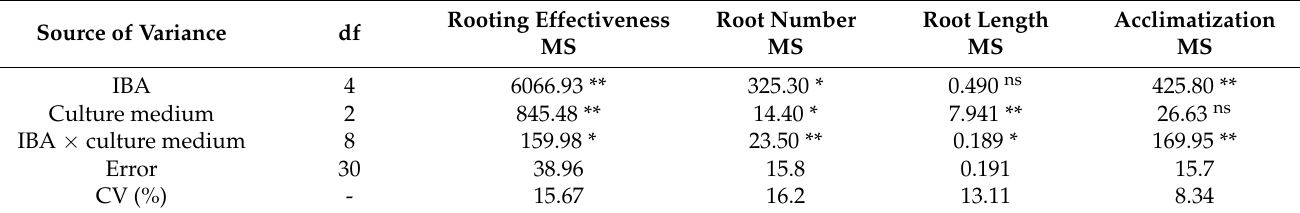
Table 3. Analysis of variance of the effects of the different concentrations of IBA and the basal culture medium type on the measured characteristics of the Pyracantha angustifolia plants grown in vitro in the rooting step, as well as the acclimatization